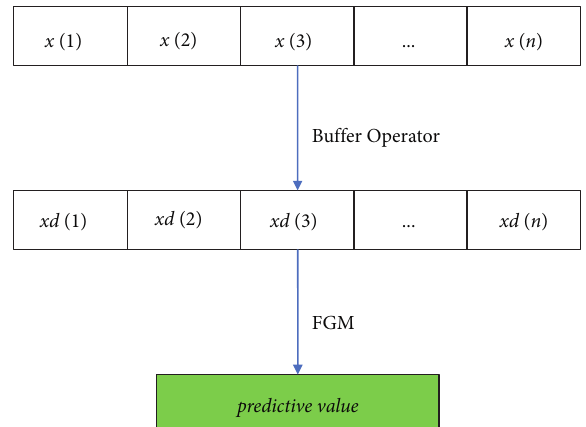
Figure 1: The basic idea of prediction with the buffer